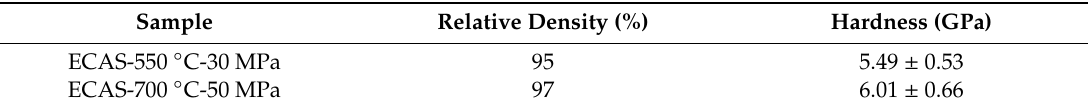
Table 2. Measured density and microhardness of ECAS-550 °C-30 MPa and ECAS-700 °C-50 MPa. Sample Relative Density